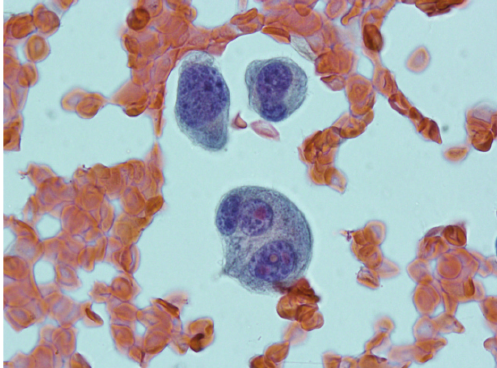
Figure 2: Atypical plasma cells with marked polymorphism and pleomorphism, increased nuclear-to-cytoplasmic ratio, binucle- ation, nuclear convolution, lobation and nuclear inclusions.